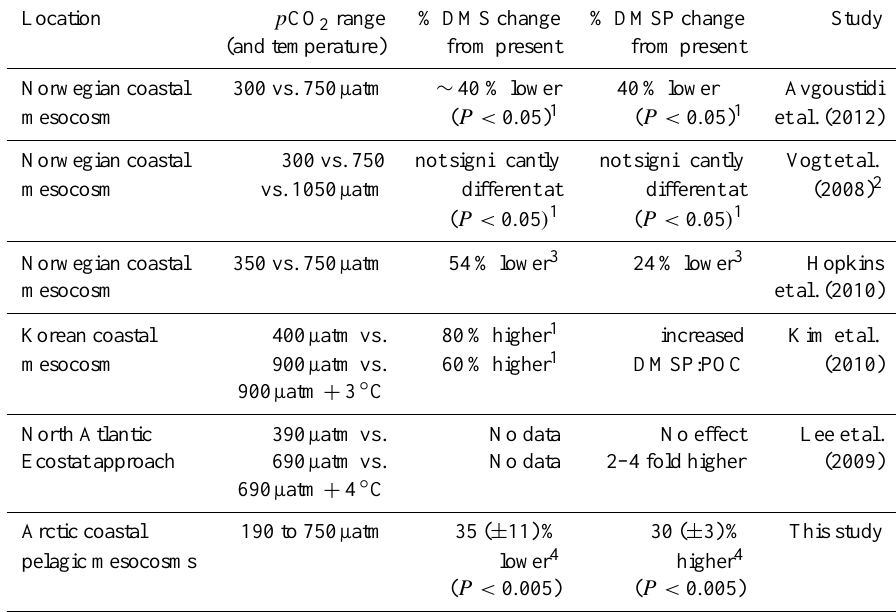
Table 3. Summary of responses of DMS and DMSP to altered p CO 2 in natural waters.